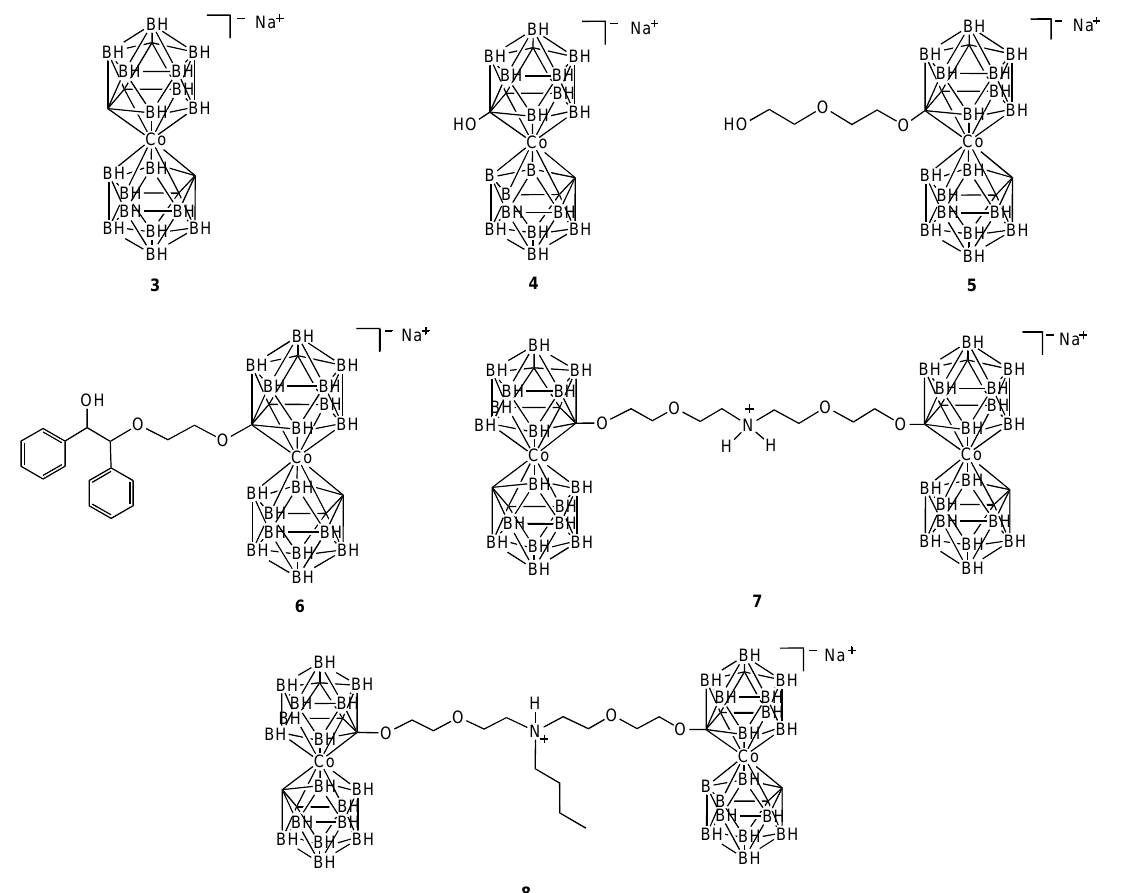
Figure 4. Structures of cobalt(III) carboranes used as HIV-1